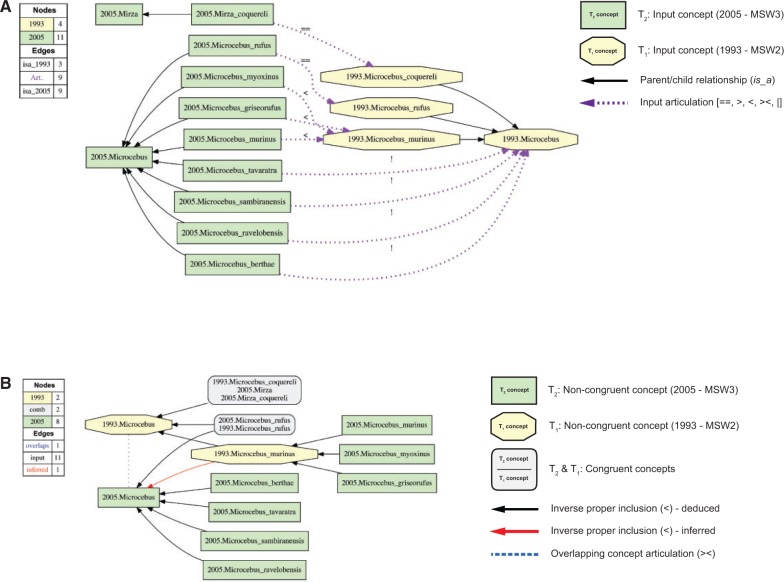
Illustration of the RCC-5 multi-taxonomy alignment approach. In all visualizations (Figs. 1, 3–7, Supplementary Figs. S3 1–13 available on Dryad), the input and aligned, noncongruent concepts sec. Groves (2005) are illustrated as green rectangles (T2). Input and aligned, noncongruent concepts sec. Groves (1993) are shown as yellow octagons (T1). Congruent sets of aligned concepts are rendered in gray rectangles with rounded corners. A) Visualization of input constraints T2 (Microcebus/Mirza sec. Groves (2005)), T1 (Microcebus sec. Groves 1993), and articulations (A) as provided by the user. Each taxonomic concept hierarchy is separately assembled via parent/child (is_a) relationships. The three concepts (Microcebus griseorufus, Microcebus murinus, Microcebus myoxinus) sec. Groves (2005) are each properly included (<) in Microcebus murinus sec. Groves (1993), based on synonymy information shown in Figure 2. Four additional species-level concepts sec. Groves (2005) are articulated as exclusive (|) of Microcebus sec. Groves (1993), because they are based on phenotypic material for which there was no equivalent in the earlier (1993) edition of MSW2 (Zimmermann et al. 1997; Rasoloarison et al. 2000). The legend indicates the number of nodes and edges for each input taxonomy, and the number of user-provided input articulations. B) Visualization (reduced containment graph) of the logically consistent alignment corresponding to the input constraints of (A), showing reasoner-inferred non-/congruent concepts and articulations (see legend). One of two consistent alignments (possible worlds) is shown. The monotypic genus-level concept Mirza sec. Groves (2005)
and its child Mirza coquereli sec. Groves (2005) are taxonomically congruent under the coverage constraint where parent concepts are circumscribed by the union of their children (Thau and Ludäscher 2007). Each is therefore also congruent with Microcebus coquereli sec. Groves (1993). The two genus-level concepts Microcebus sec. Groves (2005) and Microcebus sec. Groves (1993) are overlapping; they share two congruent subordinate concepts in the alignment, while also including reciprocally unique children. The reasoner infers 44 logically implied articulations to constitute the set of MIRs, given an input of nine articulations (see also Supplementary Materials S1 and S2 available on Dryad).